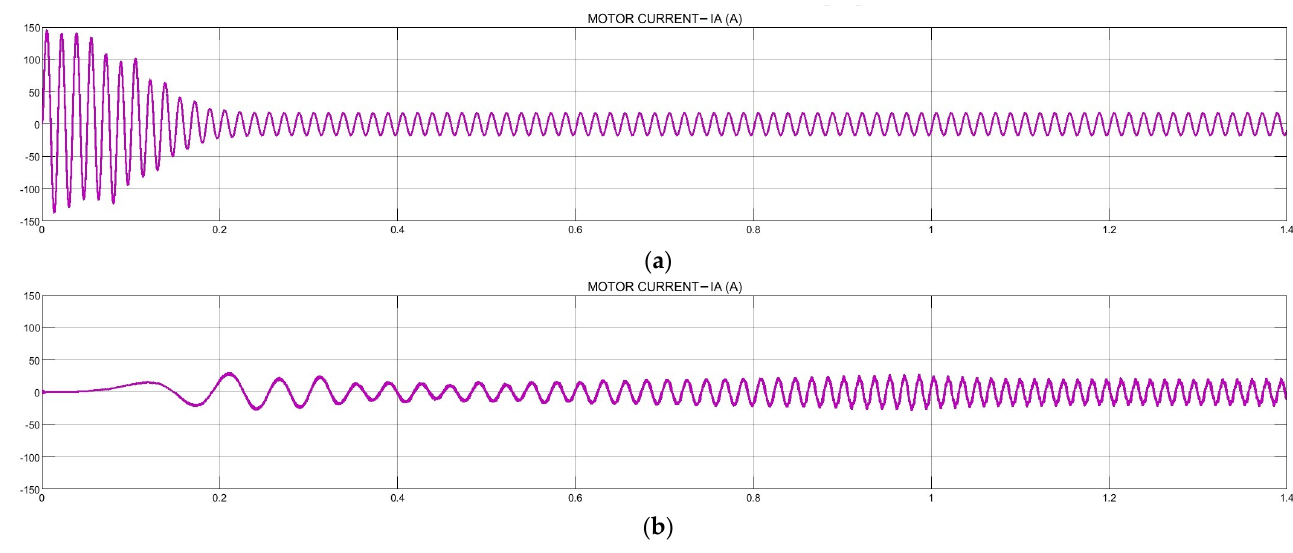
Figure 14. Currents and voltages during starting: ( a ) starting by direct connection to the grid; ( b ) starting by variable speed drive with 3 600 rpm/s ramp.